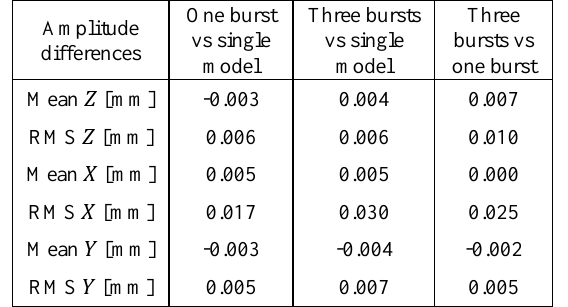
Figure 11. Example sampling density and recovered signal for the 1 Hz data (red, green and blue correspond to different bursts)